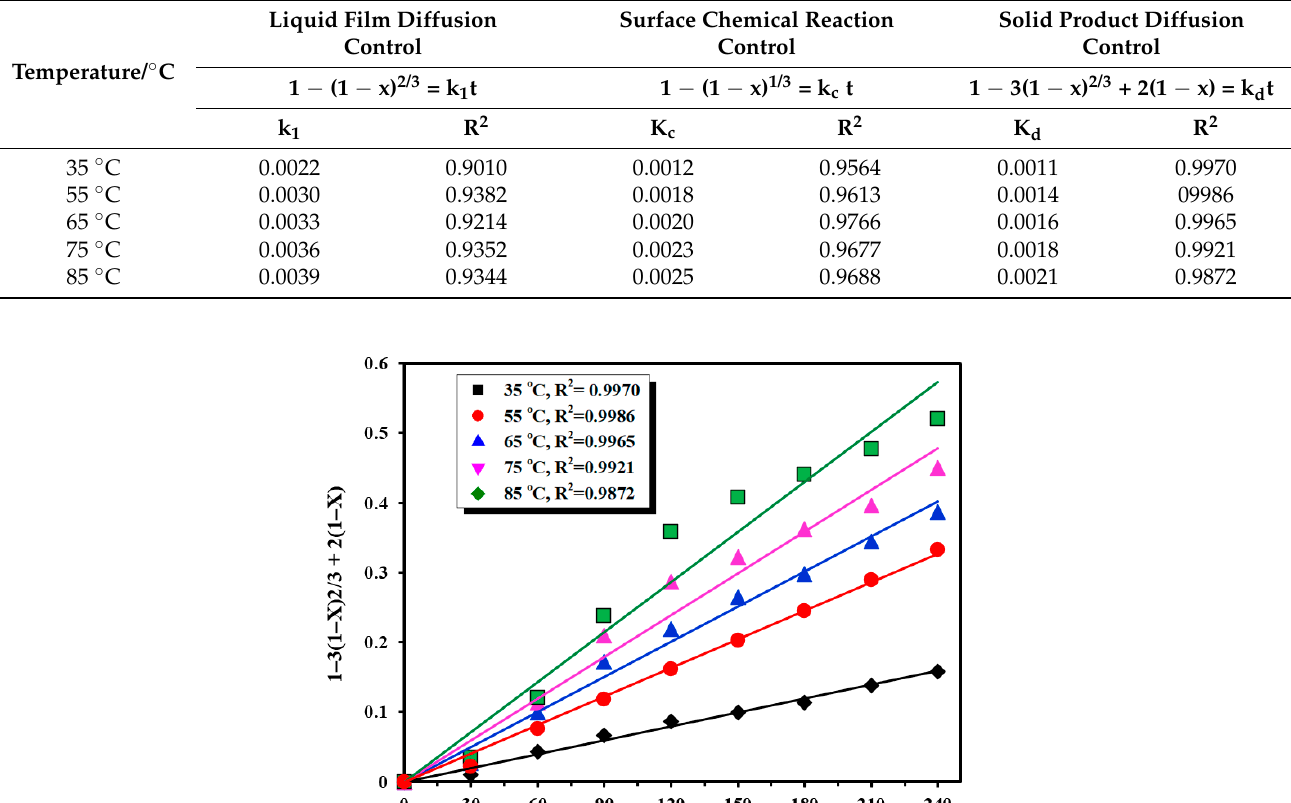
Table 7. Zinc leaching kinetics parameters of different models during the reaction time.